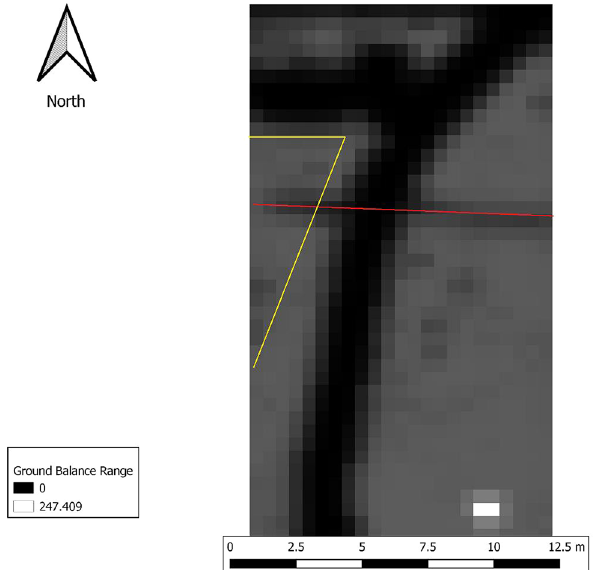
Figure 3: Interpolation map of Fir Hill Survey. Former house location outlined in yellow. Old water line and electrical lines running to house drawn in red. The front door was immediately south of the utility